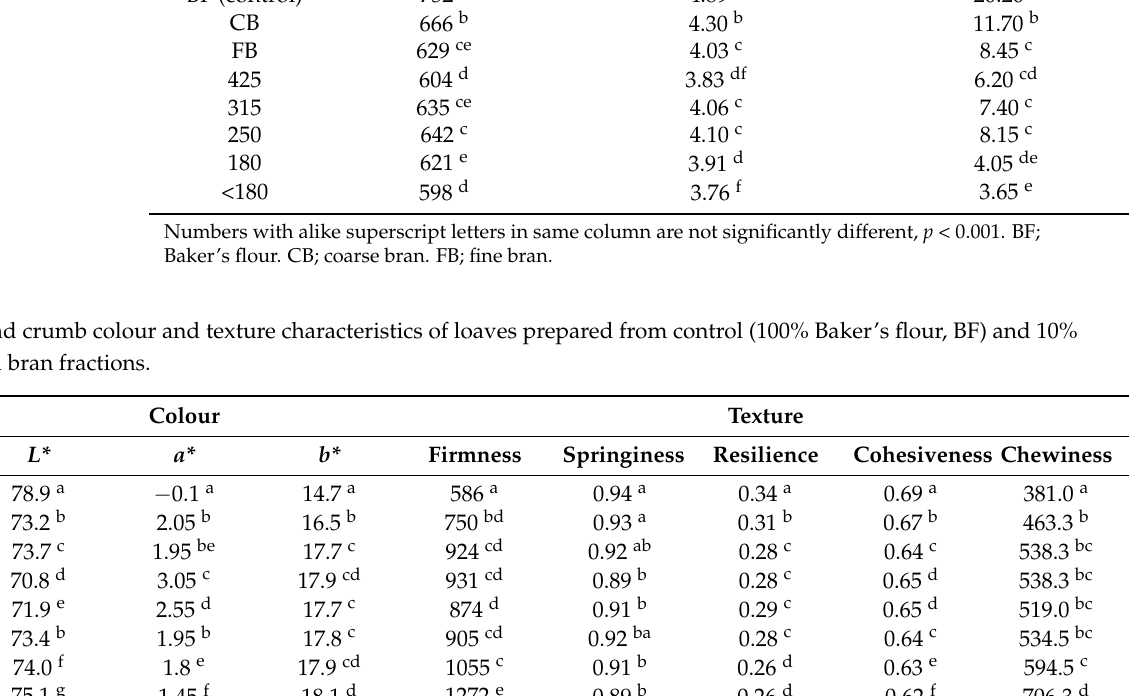
(Table 3). The LV and oven spring closest to control values was found with CB and the fraction having the greatest negative impact was <180. The FB, 315, 250 fractions had equivalent LV while 180 was lower. Although there was a high correlation between median particle size and LV (r = 0.72, p < 0.05), the 425 fraction did not follow the trend toward increased LV with a larger median particle size with low LV equivalent to <180. Table 3. Loaf volume, specific volume and oven spring of Baker’s flour bread enriched with bran fractions at 10% w/w. Loaf Volume Samples Specific Volume (cm 3 /g) (cm 3 )